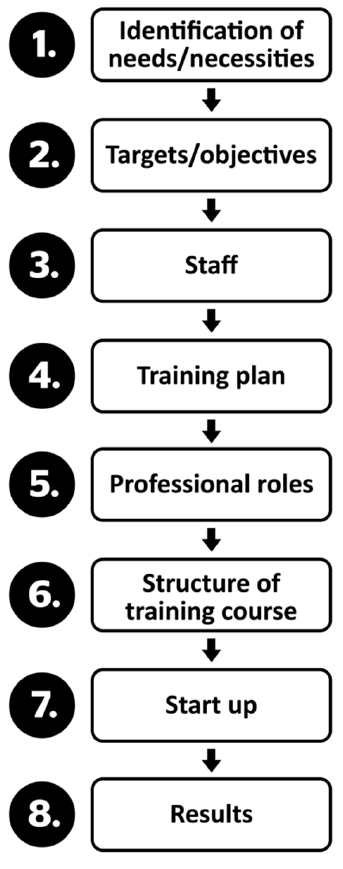
Figure 7. Intervention